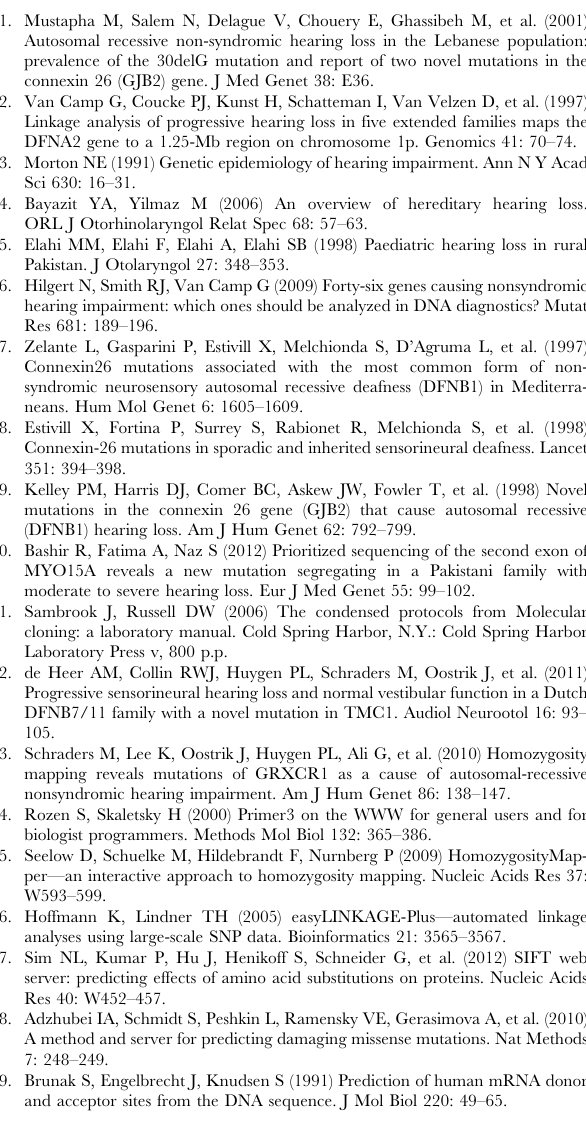
Figure S1 Multiple-alignment of the corresponding stretches of protein sequences across different species. The blue color shading represents the intensity of conservation, where the dark blue shading represents highly conserved stretch while the light blue shading denotes moderate conservation of residues across different species. A) Amino acid sequence conservation of p.Gly200 across 9 species. B) Amino acid sequence conservation of p.Phe2741 across 11 species. C) Amino acid sequence conservation of p.Val33 across 7 species. D) Amino acid sequence conservation of p.Cys24 across 10 species. E) Non- conserved residue of p.Leu7 across 10 species.